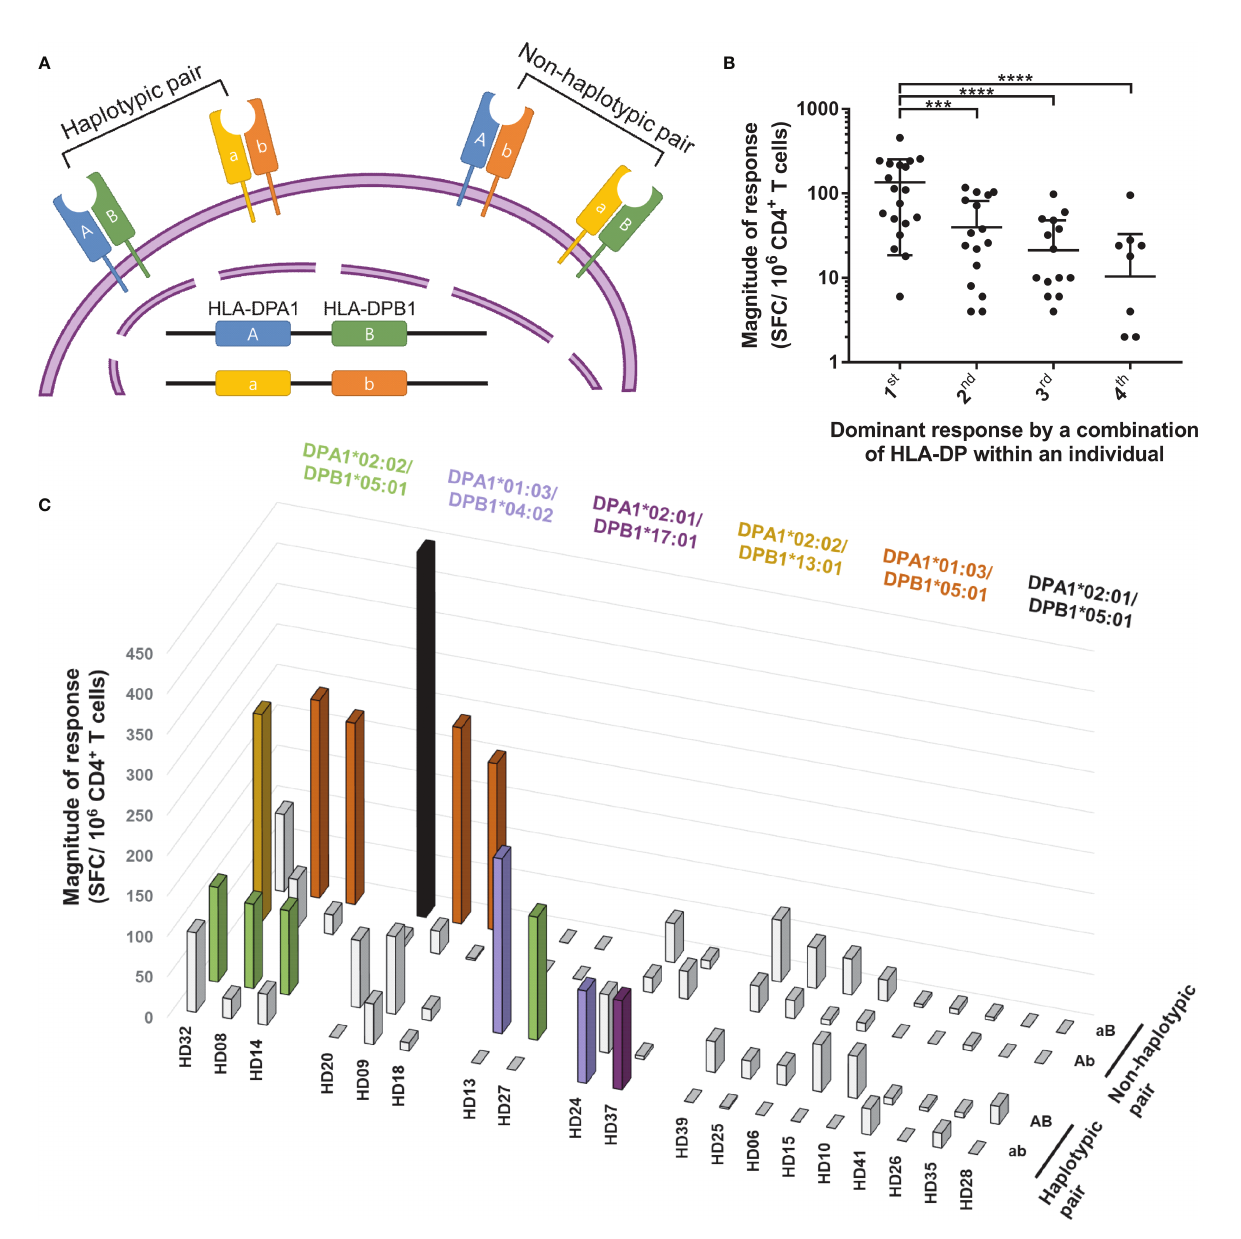
FIGURE 5 | CD4 + T cell responses restricted by HLA-DP heterodimer within individuals. CD4 + T cells were stimulated with a heterodimer-matched aAPCs pulsed with a mixture of peptide pools of spike, nucleocapsid, and membrane protein. (A) Schematic diagram showing two HLA-DP heterodimers encoded by the same allele on DPA and DPB loci (haplotypic pair), the other two HLA-DP heterodimers are encoded by different allele on DPA and DPB loci (non-haplotypic pair). (B) Dominant response by a combination of HLA-DP within an individual presents the order of highest response by an HLA-DP heterodimer within an individual. Each dot represents a response by an HLA-DP heterodimer. Data are shown as mean ± SD of 19 individuals. Statistical analysis was performed using one-way ANOVA. ***P <0.001, ****P <0.0001. (C) CD4 + T cell responses (vertical) by four HLA-DP combinations (depth) in each double heterozygous individual (horizontal). The magnitude of response above 50 SFCs/5 × 10 5 are colored and the alleles are presented with the same